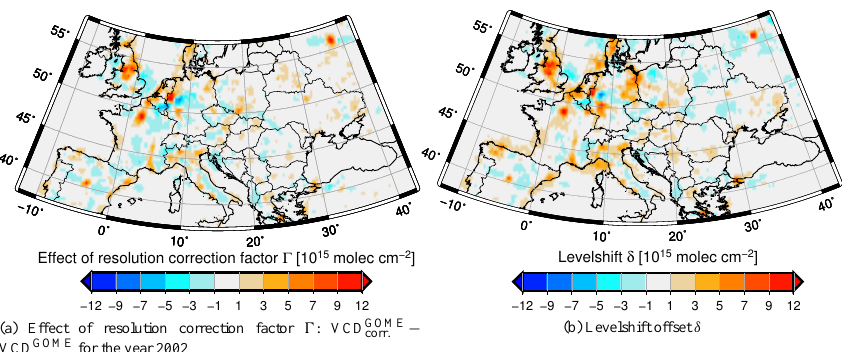
Fig. 12: Comparison of the effects of resolution correction factor 0 (applied to average GOME measurements from 2002) and level shift offset δ .